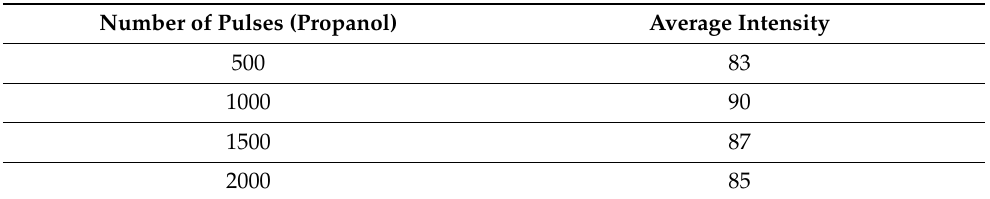
Figure 9. FTIR analysis of laser-ablated Cd exposed for 500, 1000, 1500 and 2000 laser pulses, at constant fluence value of 3.6 J cm − 2 in propanol. Table 4. Variation in the average peak intensity of IR absorption spectra, at constant fluence value of 3.6 J cm − 2 in propanol